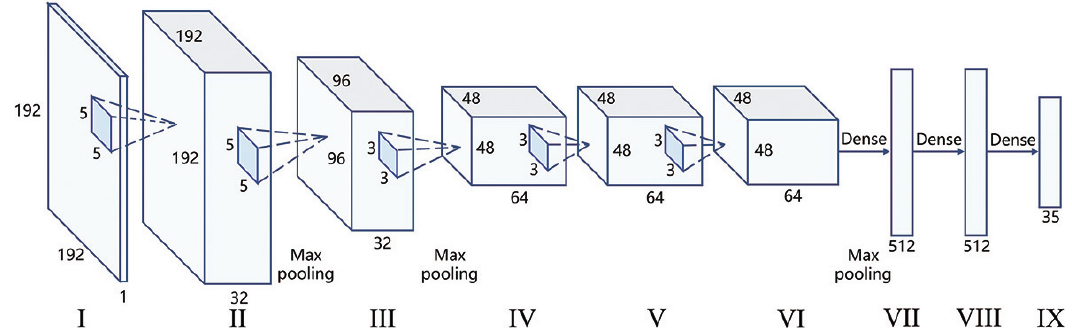
Fig. 2. The network architecture based on AlexNet. Layer I is the input pattern from SHWS; layer II – VI are convolutional layers and layer VII – IX are dense (fully connected) layers.